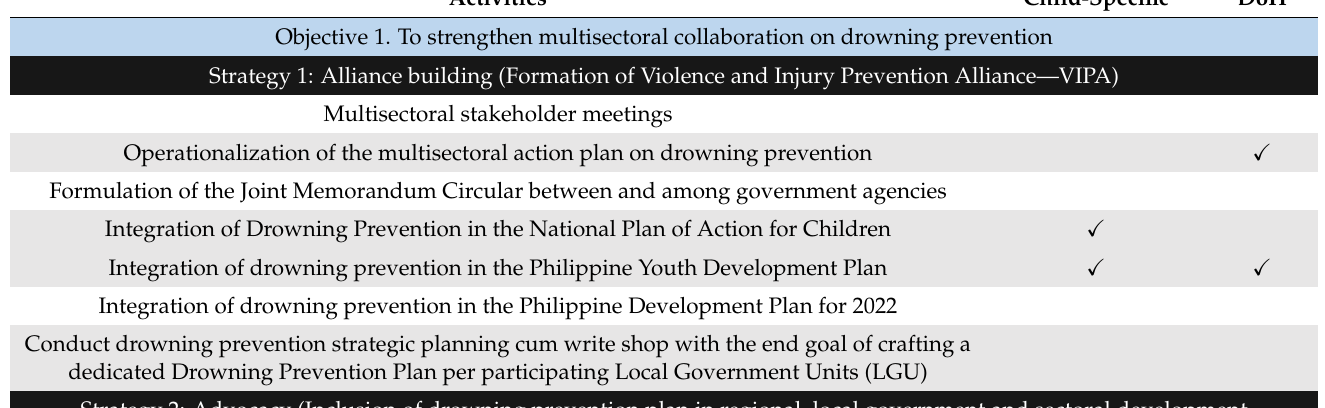
Table 2. Activities of the Multisector Action Plan on Drowning Prevention in the Philippines 2016–2026, relevance to children and consideration of determinants of health